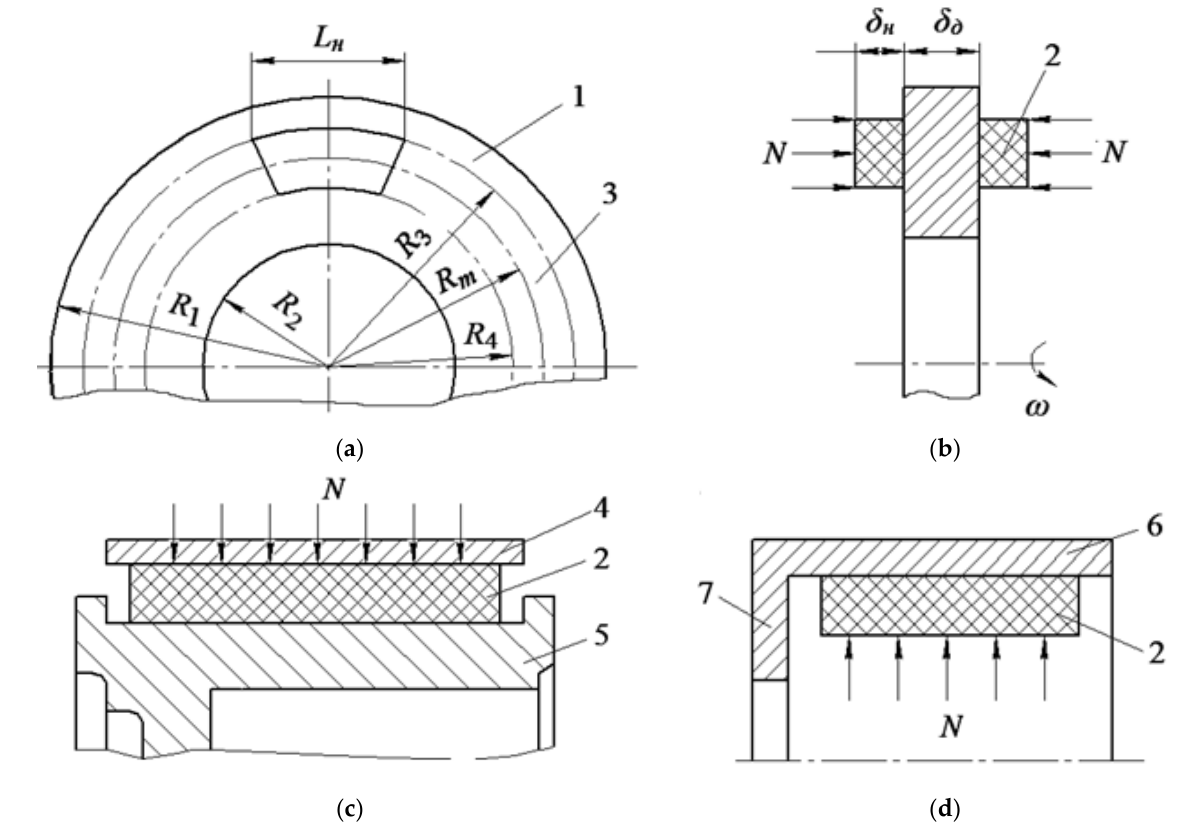
Figure 1. Diagrams of the different types of friction units of braking devices: ( a ) longitudinal section of disc-shoe; ( b ) transverse section disc-shoe; ( c ) cross-section of tape–shoe; ( d ) cross-section drum–shoe.